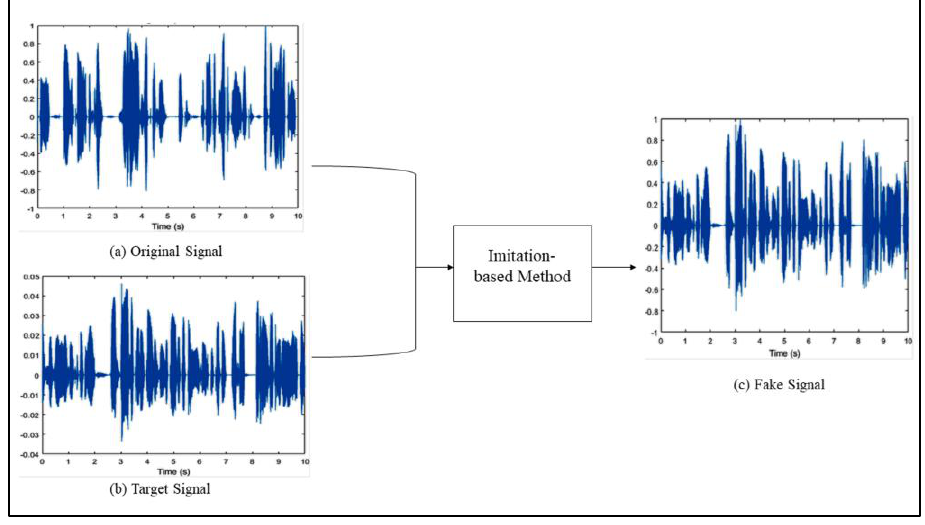
Figure 2 . Imitation-based Deepfake